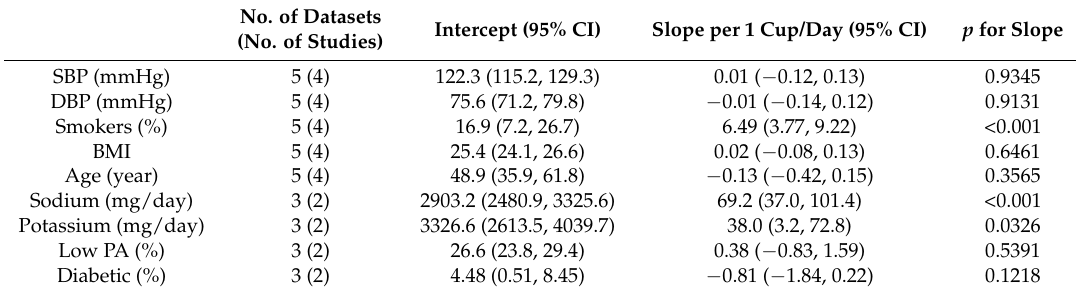
Figure 5. Risk of hypertension for linear increase of coffee consumption and selected smoking-related moderators: ( A ) total prevalence of smokers in the included cohorts; and ( B ) slope coefficients of the association between coffee intake and percentage of smokers in each category of exposure and random effects meta-regression. The area of each circle is inversely proportional to the variance of the log risk ratio estimate; continuous lines represent average risk ratios; and dashed lines represent corresponding 95% confidence intervals. Table 3. Summary of the associations between coffee consumption and selected variables.